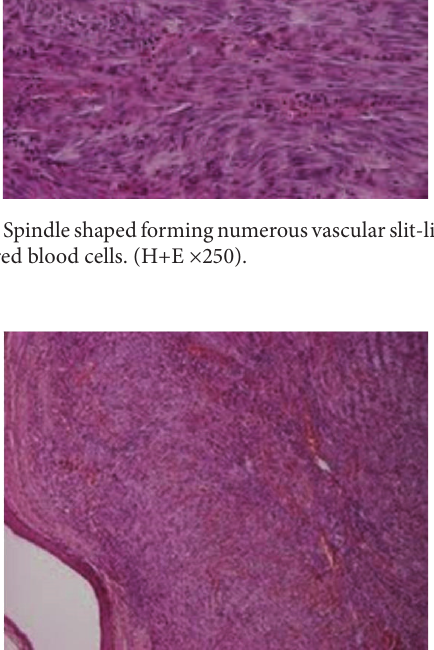
Figure 2: Blood filled vascular spaces-slits closely associated with interwearing spindle cells. (H+E × 40).